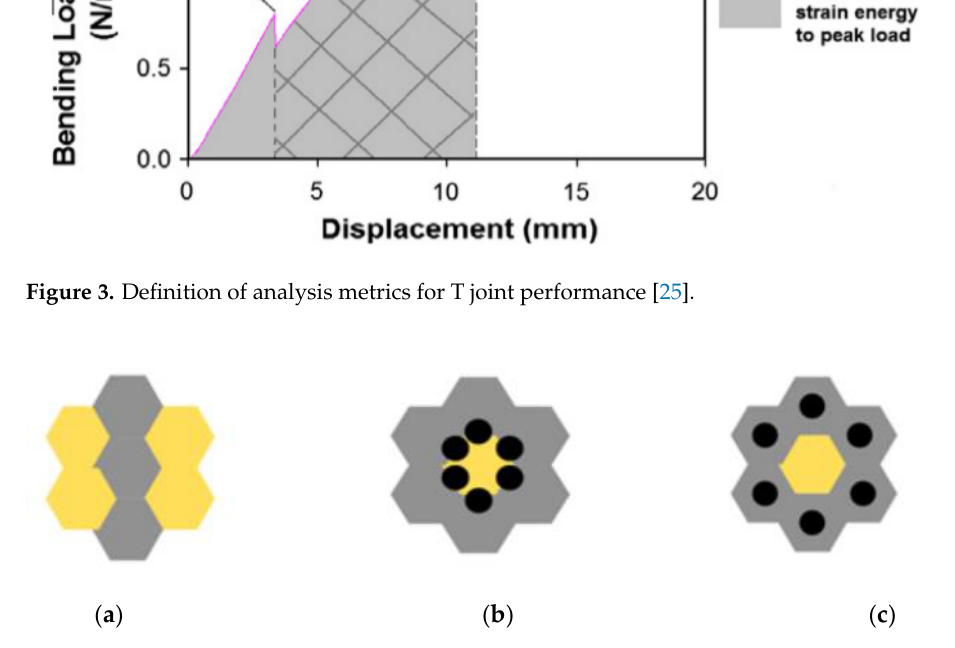
Figure 4. The various cellular structures in insects ( a ) Honeycomb Structure ( b ) Ladybug Structure- Tubular ( c ) Beetle Structure- Tubular Structure [26].